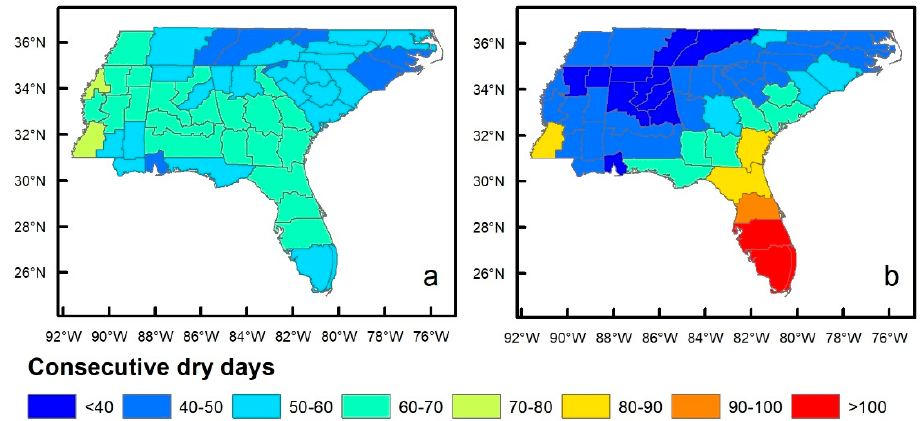
Figure 1. Observed (1950–2005) lengths of 20-year return period consecutive dry days. For warm season ( a ) and cold season ( b ).